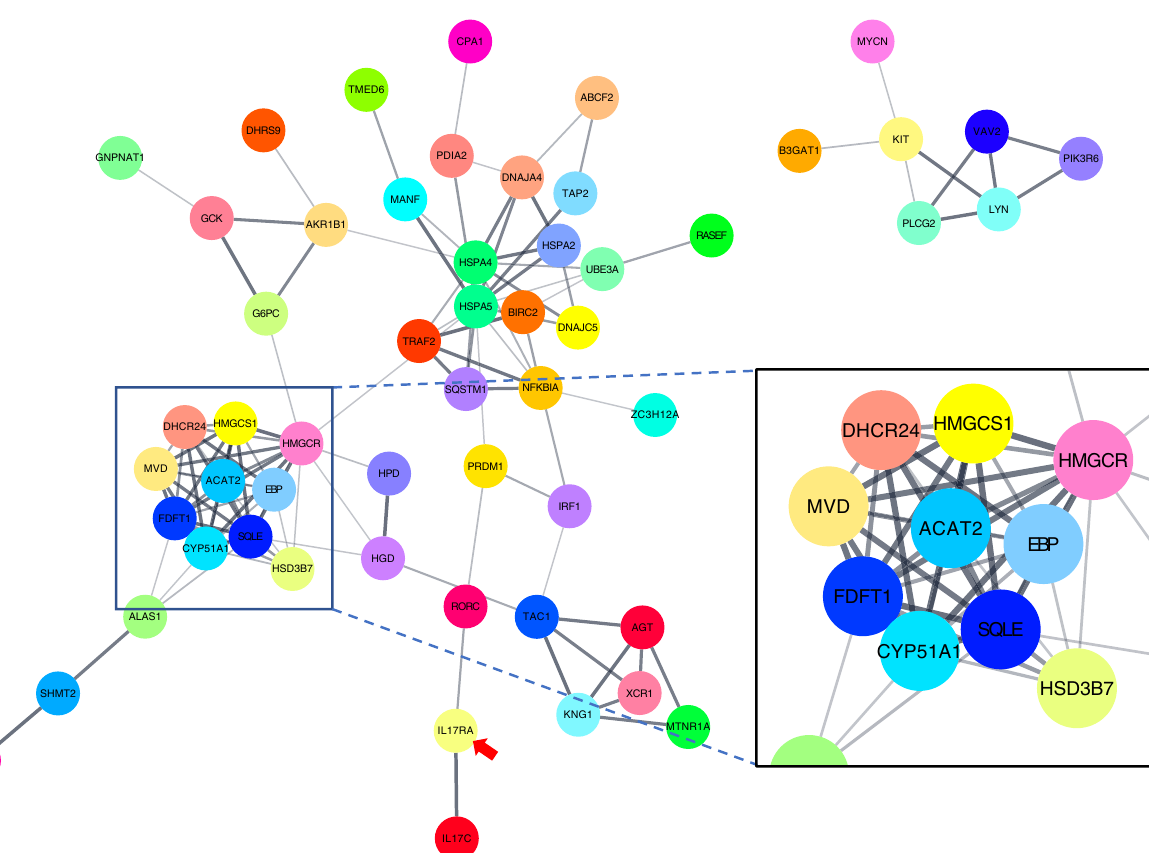
Figure 8. Predicted interactions between DEGs down-regulated in IL-17RA1-KO and IL-17RA medaka. The interaction network between these genes was defined using the String App database (Cytoscape). Of 123 DEGs identified, 47 formed the most complex cluster and contained IL-17RA. The gene cluster contained the ligands of IL-17RA, il17c , and the master transcriptional factor of IL-17-producing lymphocytes, rorc . Additionally, an aggregation of genes, including the mevalonate pathway-related genes, mvda , acat2 , hmgcs1 , and hmgcr , formed in the cluster of 47 DEGs. The red arrow points to